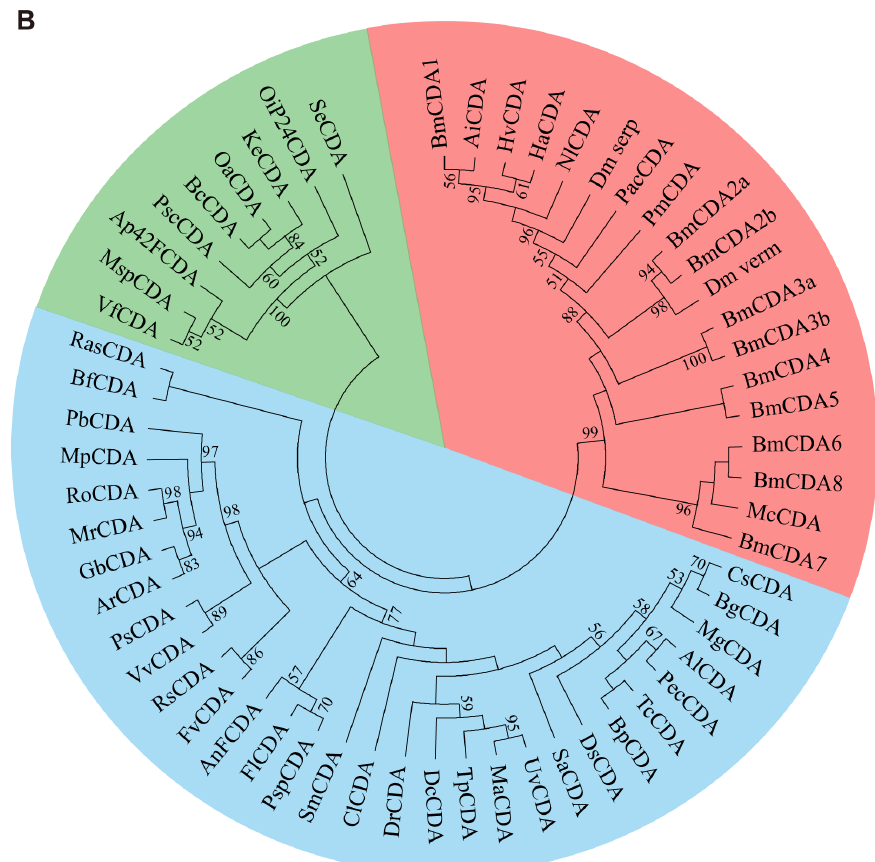
Figure 2. Amino acid sequence alignment and phylogenetic trees of putative chitin deacetylases (CDAs) from fungi, bacteria, and arthropods. ( A ) Amino acid sequence alignment of catalytic domains of carbohydrate esterase family 4 enzymes from fungi, bacteria, and arthropods. The partial amino acid sequences from Bombyx mori (Bm), Ustilaginoidea virens (Uv), Colletotrichum lindemuthianum (Cl), Blastomyces parvus (Bp), Aspergillus nidulans FGSCA4 (An), and Ralstonia solanacearum (Rs) were aligned using CLUSTALX. The conserved motifs (motifs 1–5) are highlighted with black lines and the black boxes represent motif 4–5 for fungi and bacteria. The background of amino acid residues is based on the degree of conservation (black = 100%, dark gray = 80%, light gray = 60%). ( B ) Phylogenetic trees of CDAs from fungi (blue), bacteria (green), and arthropods (red). The partial amino acid sequences from Bombyx mori (Bm), Agrotis ipsilon (Ai), Heliothis viriplaca (Hv), Helicoverpa armigera (Ha), Nilaparvata lugens (Nl), Drosophila melanogaster (Dm), Panonychus citri (Pac), Penaeus monodon (Pm), Mamestra configurata (Mc), Colletotrichum salicis (Cs), Blumeria graminis (Bg), Magnaporthe grisea (Mg), Aspergillus luchuensis (Al), Penicillium chrysogenum (Pec), Talaromyces cellulolyticus (Tc), Blastomyces parvus (Bp), Diplodia seriata (Ds), Scedosporium apiospermum (Sa), Ustilaginoidea virens (Uv), Metarhizium anisopliae (Ma), Trichoderma parareesei (Tp), Drechmeria coniospora (Dc), Diplocarpon rosae (Dr), Colletotrichum lindemuthianum (Cl), Sphaceloma murrayae (Sm), Pestalotiopsis sp. (Psp), Fusarium langsethiae (Fl), Aspergillus nidulans FGSCA4 (AnF), Flammulina velutipes (Fv), Rhizoctonia solani (Rs), Volvariella volvacea (Vv), Puccinia sorghi (Ps), Amylomyces rouxii (Ar), Gongronella butleri (Gb), Mucor racemosus (Mr), Rhizopus oryzae (Ro), Malassezia pachydermatis (Mp), Phycomyces blakesleeanus (Pb), Brevibacillus formosus (Bf), Ralstonia solanacearum (Ras), Vibrio furnissii (Vf), Marinomonas sp. MWYL1 (Msp), Acinetobacter pittii 42F (Ap42F), Pseudomonas chlororaphis (Psc), Bacillus cereus (Bc), Oleispira antarctica RB-8 (Oa), Komagataeibacter europaeus (Ke), Oceanibaculum indicum P24 (OiP24), and Salmonella enterica (Se) were aligned using the CLUSTALX. Phylogenetic trees were constructed using MEGA6 software with the maximum likelihood method. A bootstrap analysis of 1000 replications was used and bootstrap values are shown in the